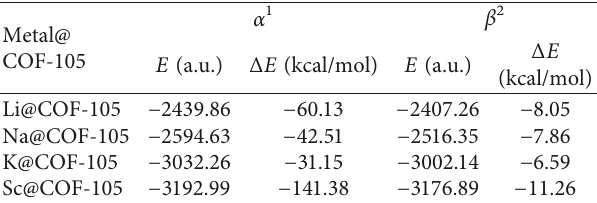
Figure 1: The cluster model of covalent organic frameworks (COF- 105). Dark yellow: Si; dark grey: C; grey: H; pink: B; red: O. Table 1: The energy of optimized metal@COF-105 and interaction energy between the doped metal and the COF-105 cluster